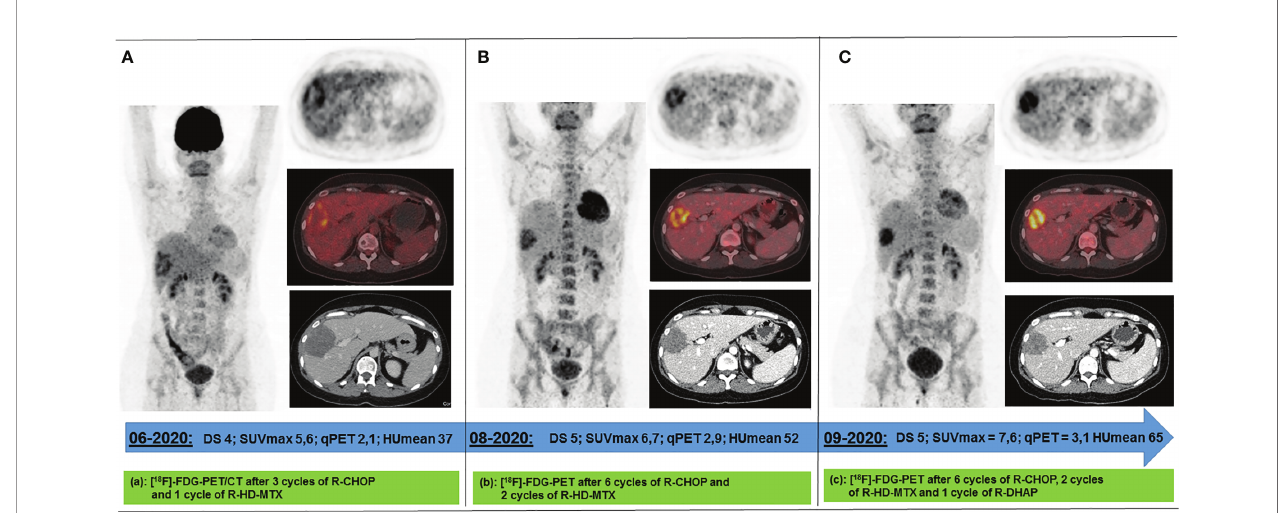
FIGURE 2 | Response 18 F-FDG PET scans acquired between Jun 2020 and Sep 2020 following 4 (A) , 8 (B) , and 9 (C) cycles of immunochemotherapy. The only remaining metabolically active lesion after 4 immune-chemotherapy cycles has been a circumscribed area in the right liver lobe. Under continued (B) and intensi fi ed immunochemotherapy (C) , its metabolism increased while its volume decreased. DS, Deauville score; SUV max , maximum standard uptake value; qPET, quantitative positron emission tomography; HU mean , average value of Houns fi eld